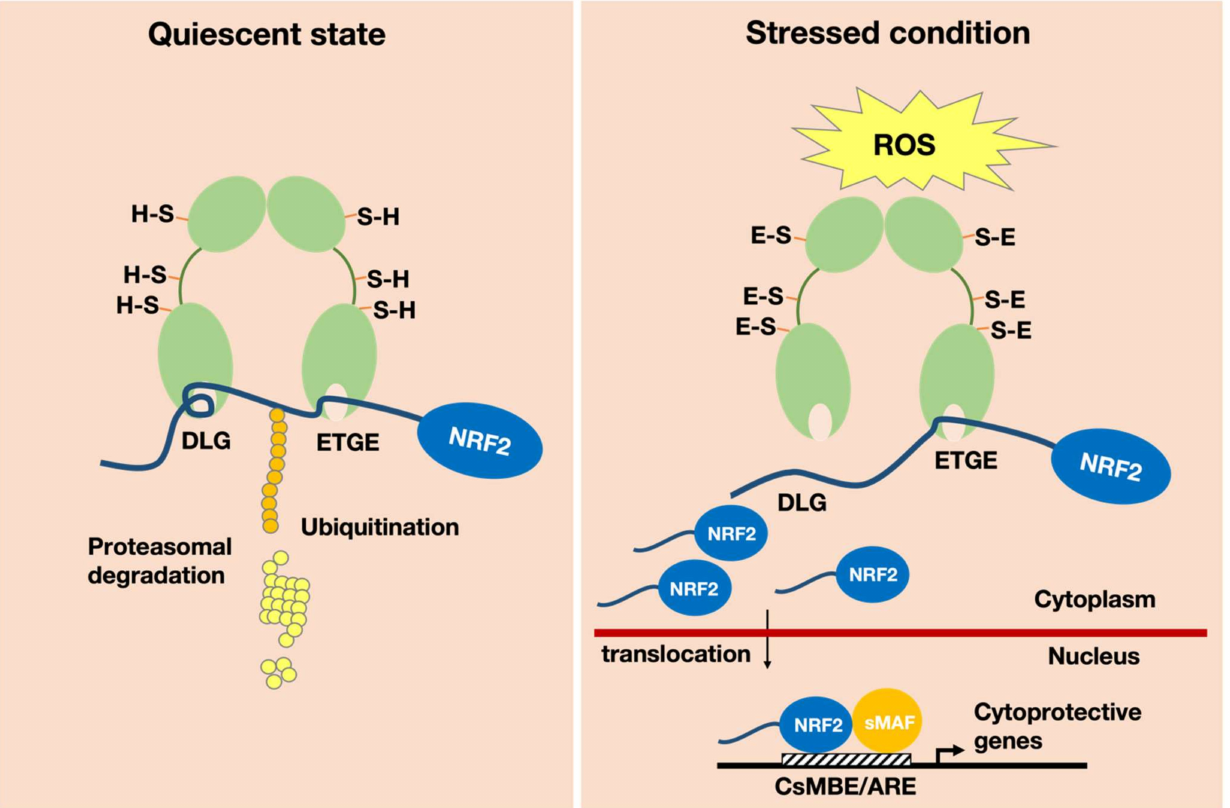
Figure 1. Structural and functional basis of the KEAP1–NRF2 system. The transcription factor NRF2 is a master regulator of the response to oxidative and electrophilic stresses in the human body. Under quiescent conditions, NRF2 is targeted for ubiquitination by the principal negative regulator KEAP1 (left). KEAP1 is a cysteine-thiol-enriched molecule that is the stress sensor and ubiquitin ligase of NRF2. Reactive oxygen species (ROS) and electrophiles induce modification of the cysteine-thiol moieties on KEAP1, facilitating the escape of NRF2 from ubiquitination. NRF2, thus, accumulates in the cytoplasm, leading to its translocation into the nucleus. NRF2 forms a heterodimer with the sMAF molecule and binds to a CNC–sMaf binding elements (CsMBE) or antioxidant-responsive element (ARE) motif, resulting in the transcription of a battery of antioxidant, cytoprotective, metabolizing and anti-inflammatory enzymes